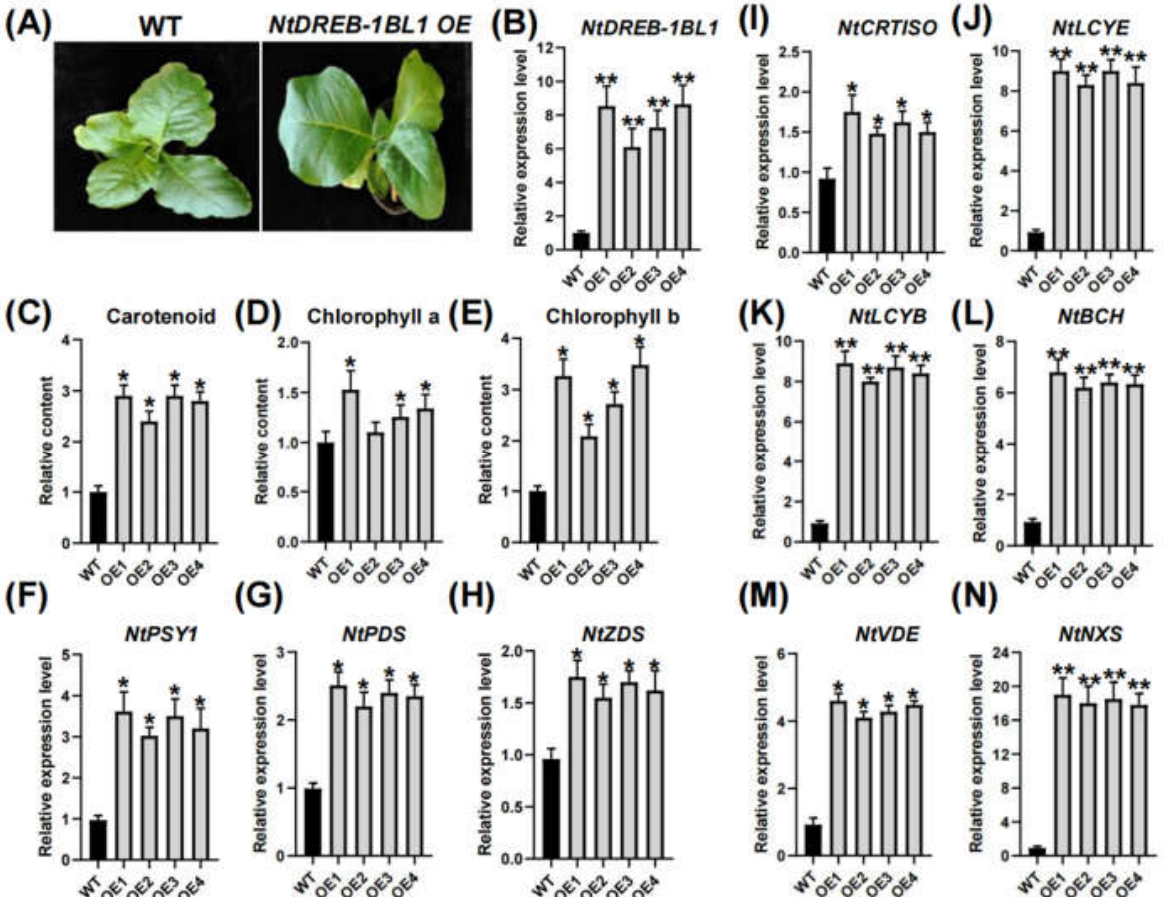
Figure 3. Overexpression of NtDREB-1BL1 improved carotenoid contents and expression of genes related with carotenoid biosynthesis. ( A ) Phenotype of NtDREB-1BL1 OE transgenic tobacco. ( B )